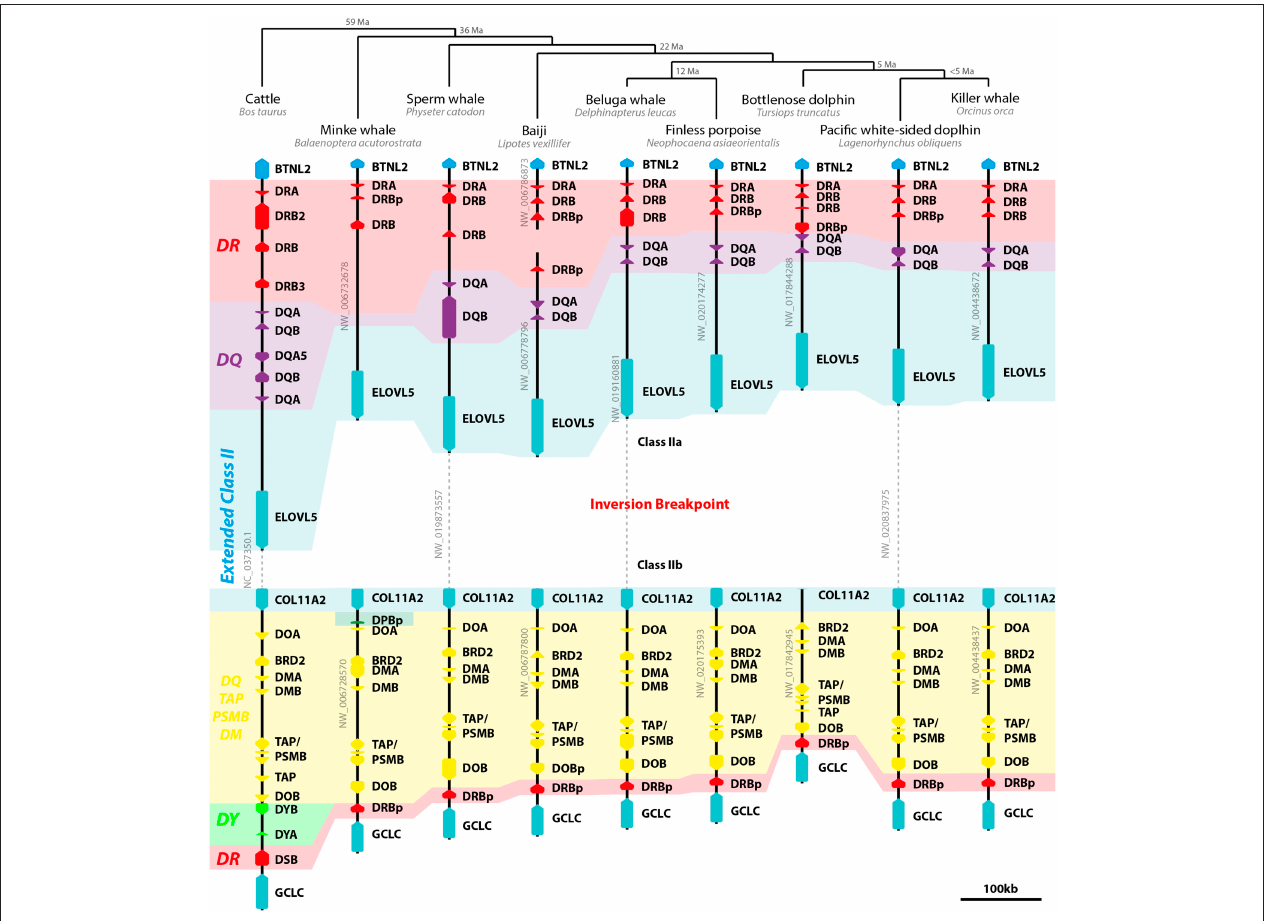
FIGURE 4 | Model of cetacean class II MHC evolution. On the top of image, the Cetartiodactyla phylogeny and divergence time (Ma, million years before present) proposed by Zurano et al. ( 41). On the left, cattle class II MHC region is depicted as an outgroup and model of the terrestrial Cetartiodactyla genome organization. Dashed lines represent regions of the scaffolds excluded for clarity purposes, which are not to scale. Arrows represent genes and pseudogenes (shown as “p” in the end of the gene’s name). Only informative scaffolds of the MHC structure are displayed. In color, a schematic view of class II loci helps to understand the evolution of class II loci ( DR —red; DQ —purple; DP —green; DY —light green; DO/TAP/PSMB/DM —yellow). TAP/PSMB represents TAP1 , TAP2 , PSMB8 , PSMB9